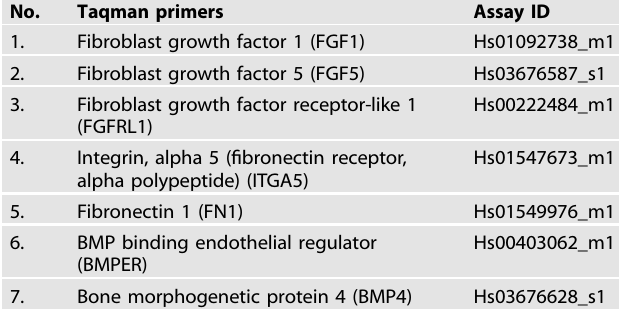
Table 1. List of TaqMan primers for microarray